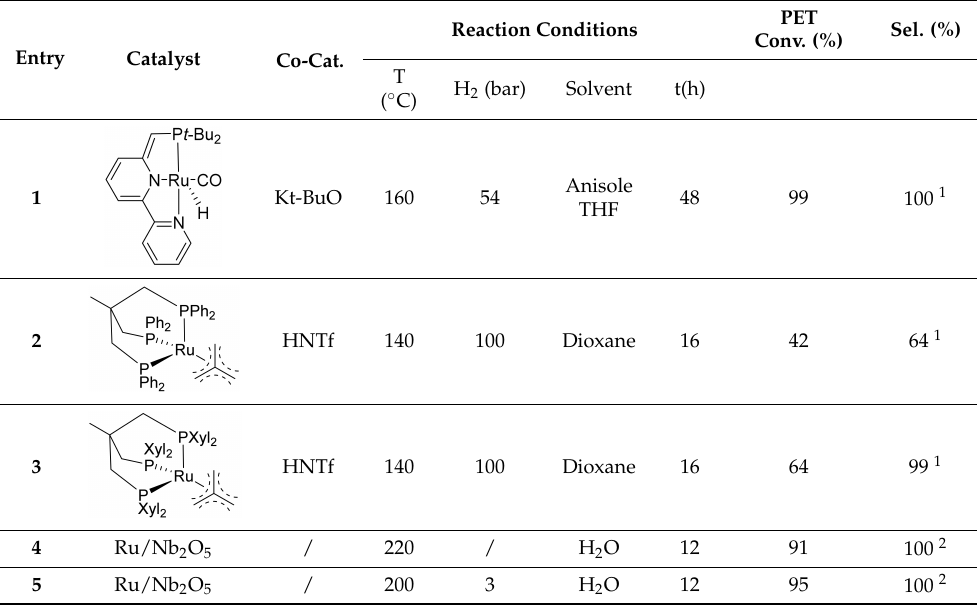
Table 1. Phosphine ligands of Milstein-type Ru–PNN